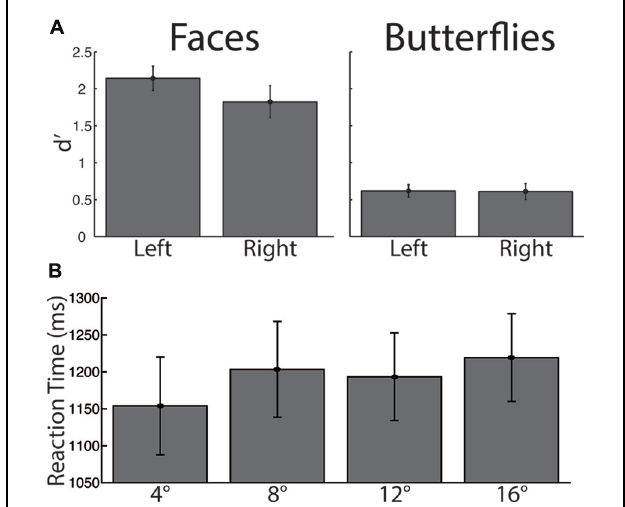
FIGURE 5 | Recognition performance by stimulus category and starting side. (A) Discrimination performance, measured by d (cid:3) . There was significantly lower discrimination for butterflies than for faces, and significantly greater face discrimination for the left than for the right starting side (B) Reaction time. The longest distance elicited significantly longer reaction times than the shortest